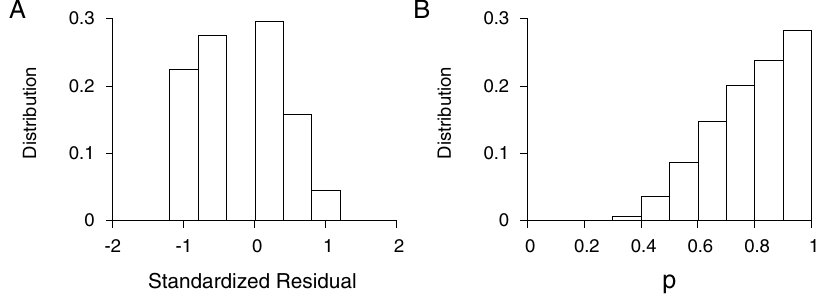
Figure 7. Biomarker dynamics validation. ( A ) The standardized residual of biomarkers of 31 incident specimens from 15 WIHS subjects. Each WIHS subject’s first specimen’s days post infection was randomly assigned within the maximum and minimum days post infection (Table 1) and subsequent specimens’ days post infection were based on specimen collection time intervals. This sampling was repeated 10,000 times to obtain each specimen’s biomarker value as a function of days post infection, yielding 10,000 sets of 31 standardized residuals. These standardized residuals were distributed within [ − 2:2], implying that the WIHS sequence dataset conformed to the GSI dynamics inferred from 438 independent specimens presented in Fig. 3A. ( B ) The p-value distribution of 10,000 Anderson-Darling tests. All p values were above 0.28, suggesting that the GSI distribution of the WIHS validation dataset is statistically consistent with the model estimate in Fig.